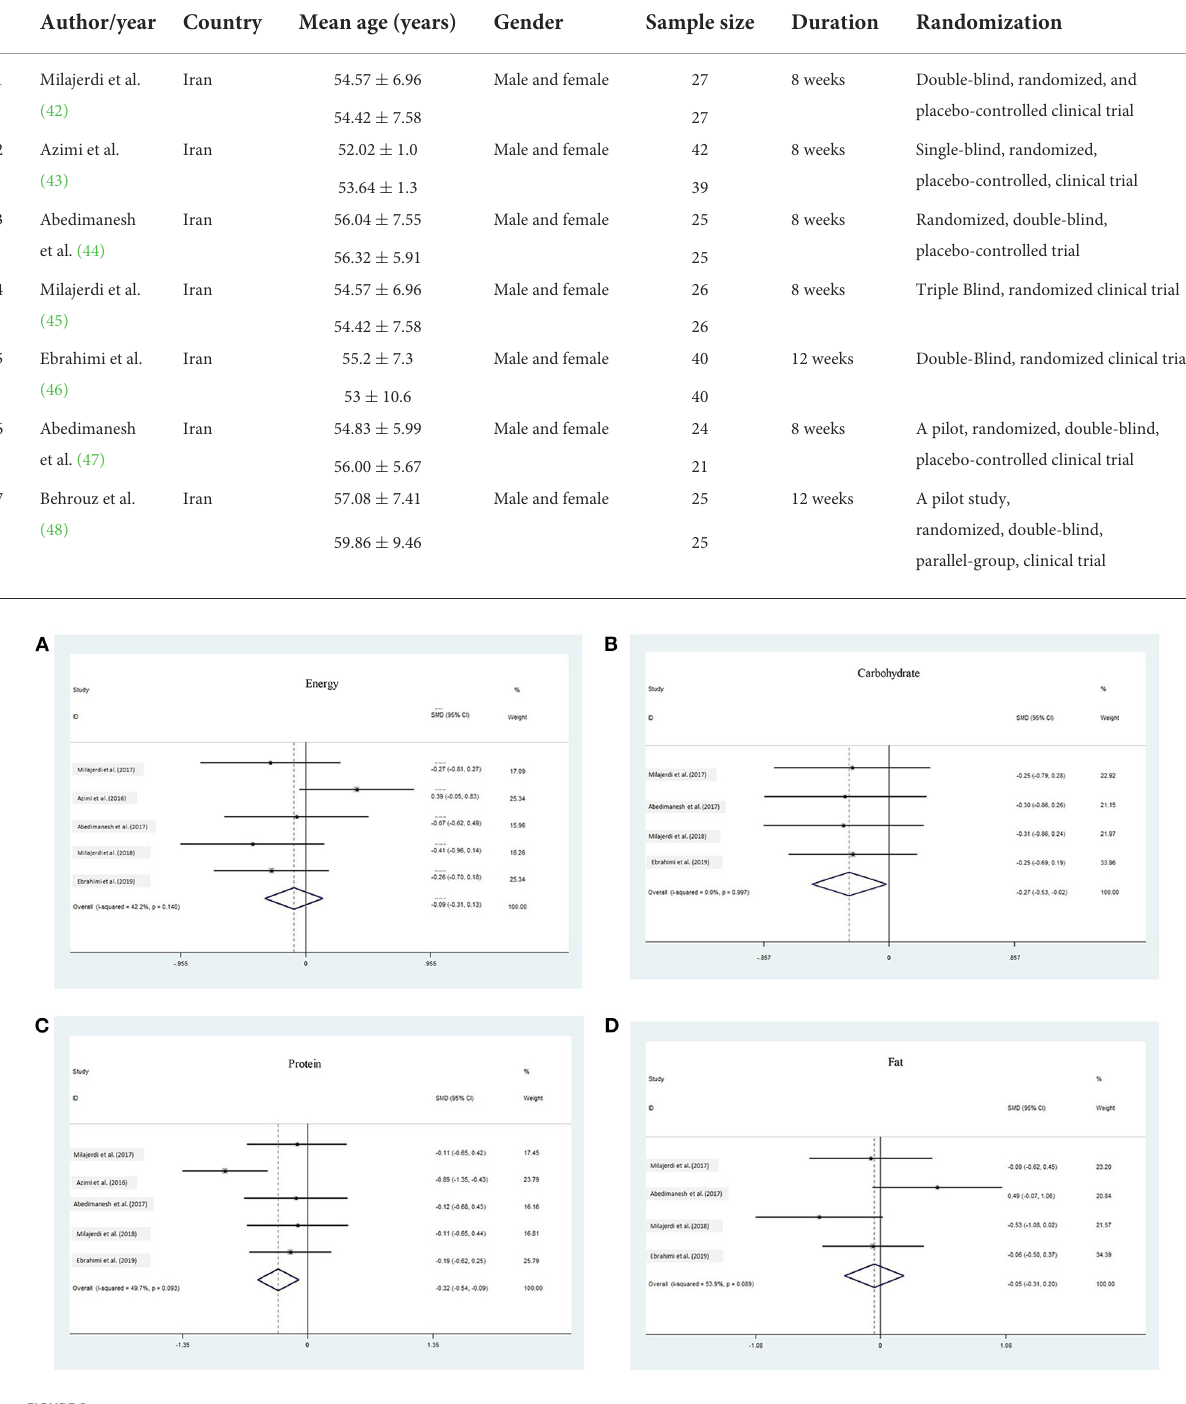
TABLE 1 Demographic characteristics of the included studies.